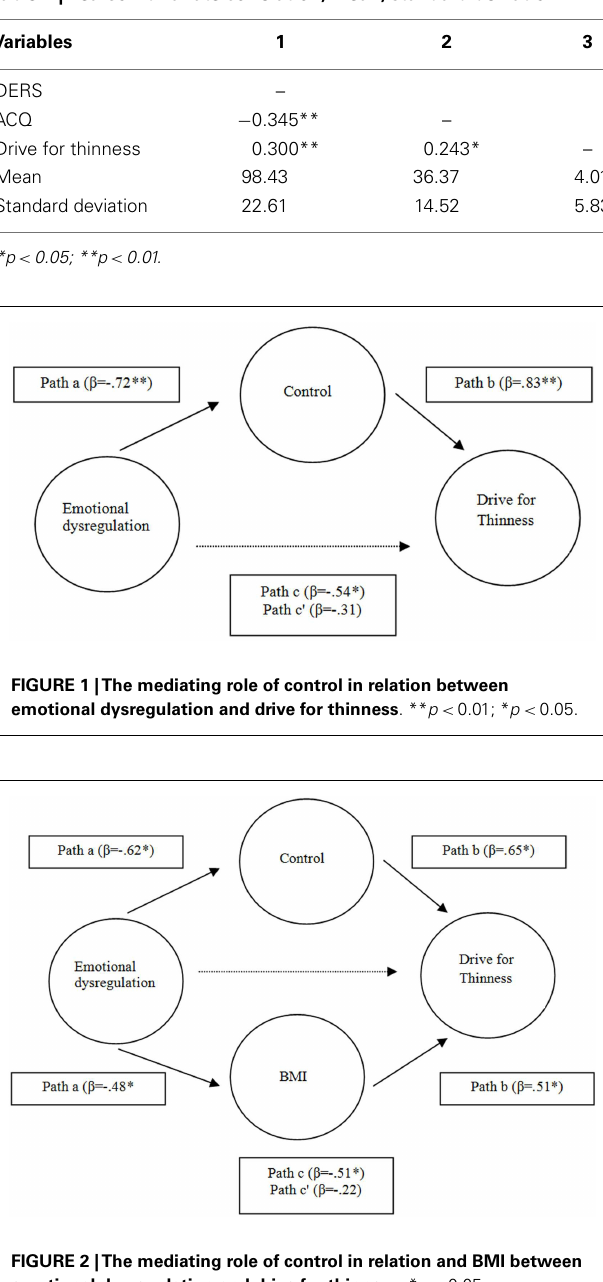
FIGURE 2 |The mediating role of control in relation and BMI between emotional dysregulation and drive for thinness . * p <